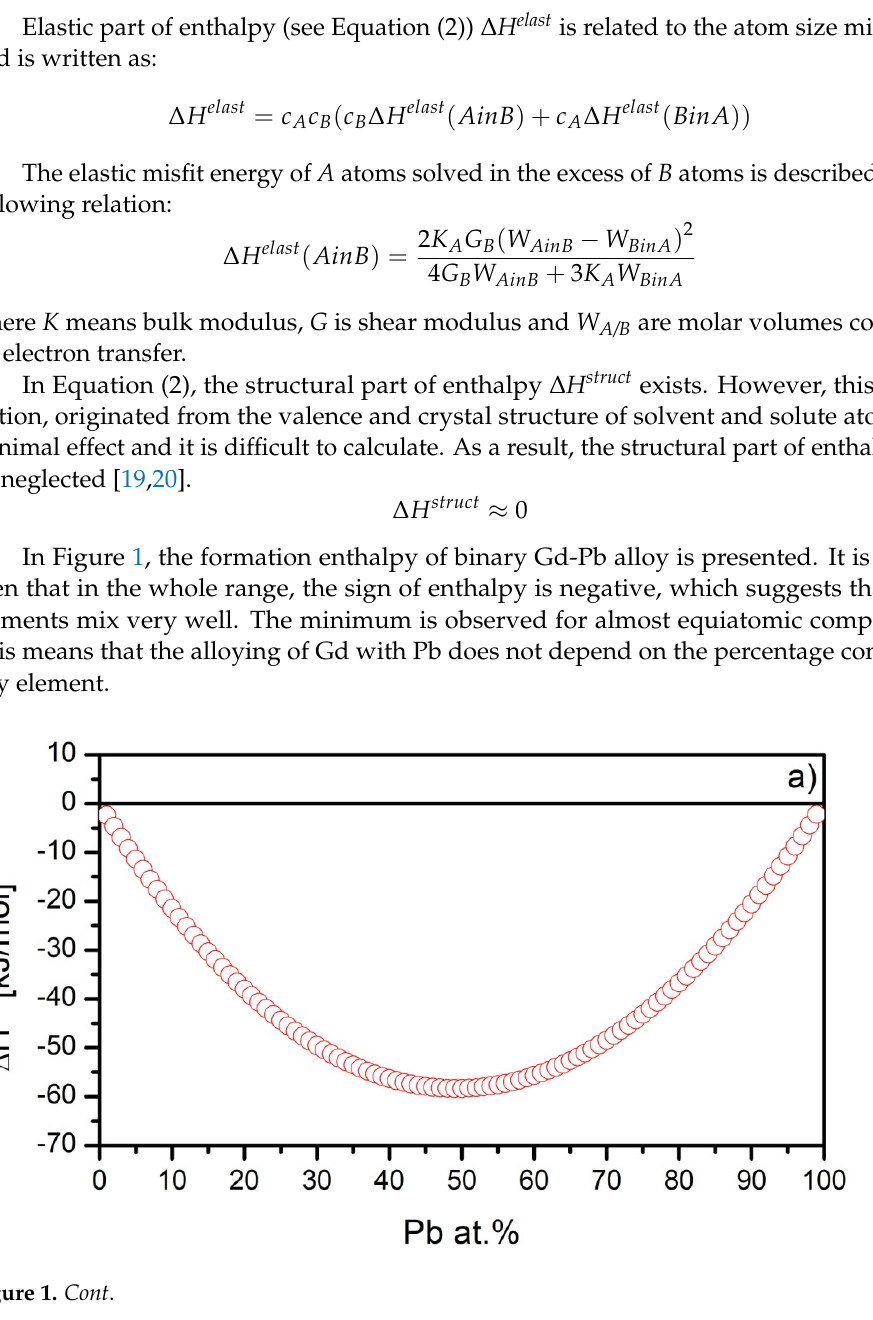
Figure 1. The formation enthalpy of solid solution Gd-Pb binary alloy ( a ) and selected range used in the present paper ( b ). In Figure 2, the XRD patterns of all studied samples are depicted. The analysis of the XRD pattern revealed a biphasic structure, which was built by hexagonal Gd(Pb) (space group P6 3 /mmc no. 194) and hexagonal Gd 5 Pb 3 (Mn 5 Si 3 - type, space group P6 3 /mcm no. 193) phases. Moreover, a small amount of the cubic GdO 1.5 (space group Fm3m no. 225) phase was detected, the presence of which was probably caused by oxidation of the sam- ple surface during measurements. The results of the Rietveld analysis are collected in Ta- ble 1.